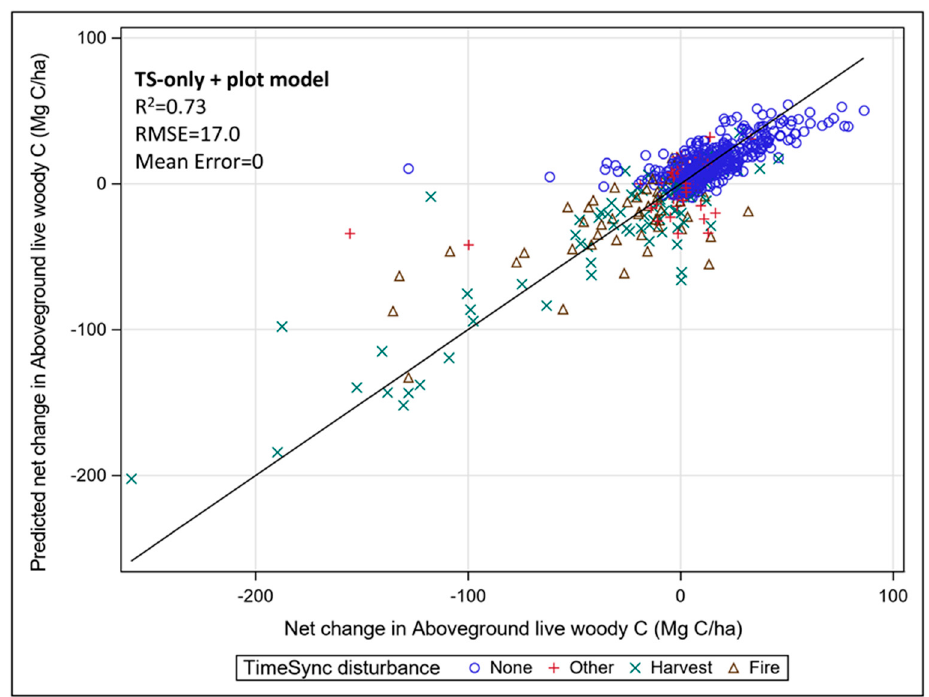
Figure 6. Predicted vs. actual net change in aboveground live woody C (AWC) by TS disturbance type, based on the full set of available TS and plot variables.